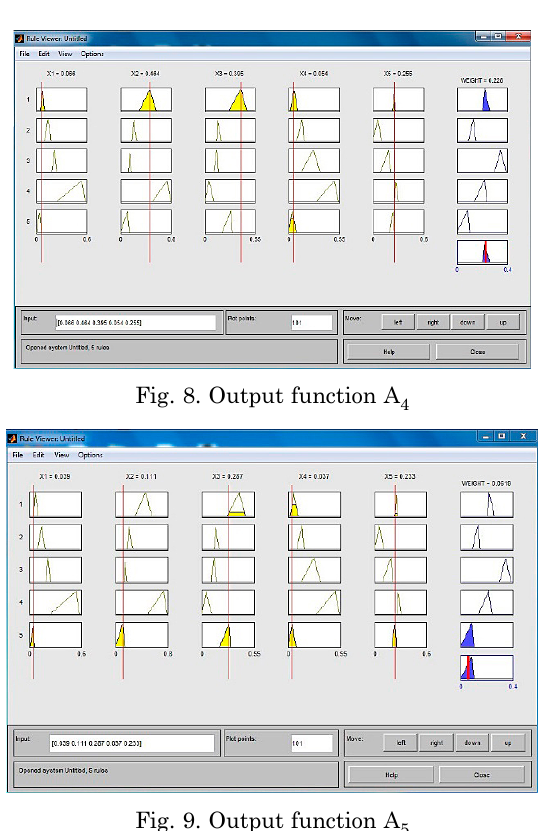
fig. 9. output function a